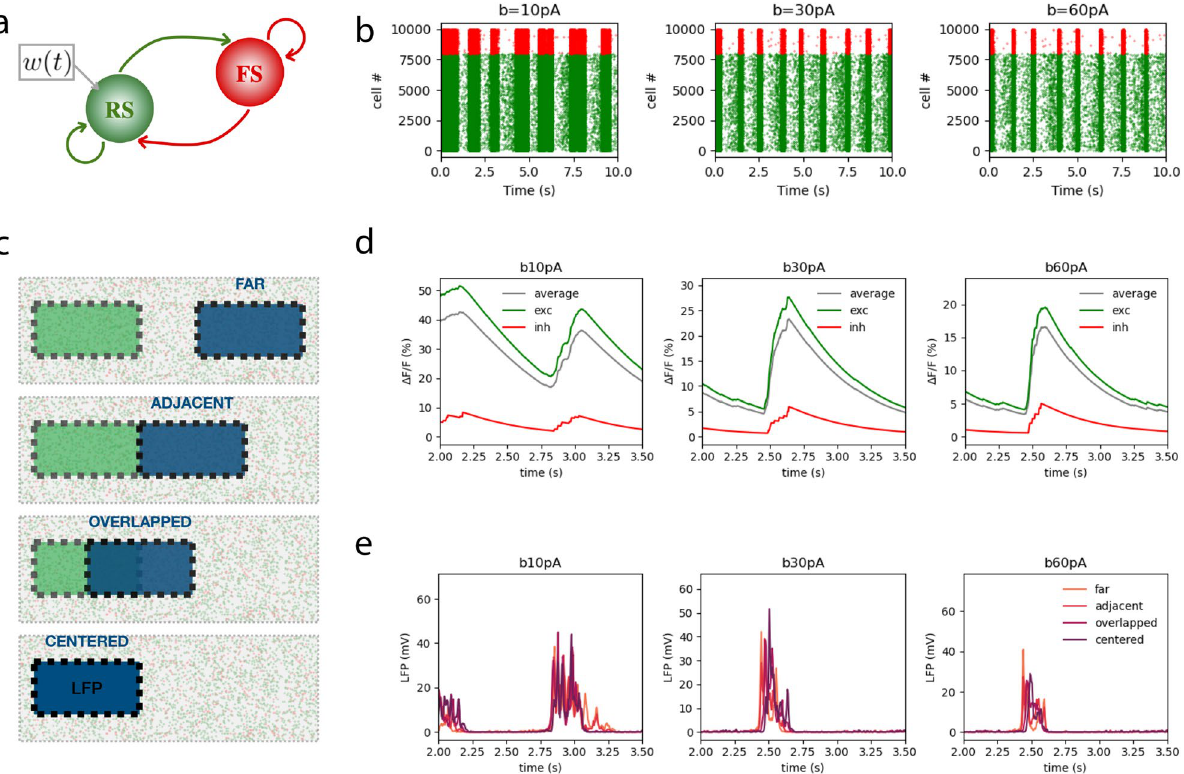
Figure 7. Simulations of calcium and LFP signals: a. The spiking network model has two populations: one of fast spiking (FS) inhibitory neurons and another of regular spiking (RS) excitatory neurons, which are affected by adaptation ( ω( t ) ). b. Raster plots of the spikes of each population (red for inhibitory cells and green for excitatory cells) simulated under increasing adaptation strength (from left to right the strength of adaptation is b = 10, 30 and 60 pA , respectively). c. 2D plane in which the 10k simulated neurons are located and position of the LFP area (blue) relative to the calcium area (FOV, green) in each condition (the distance between centers in the centered , overlapped , adjacent and far conditions are 0, 300, 600 and 900 µ m , respectively). Dimensions 2 2 of the total area: 1700 x 600 µ m ; FOV and LFP areas: 600 x 300 µ m d. Calcium signal of the excitatory (green), inhibitory (red) and average (grey) populations, simulated under increasing adaptation strength as in b. e. LFP signal in each condition in c, simulated under increasing adaptation strength as in